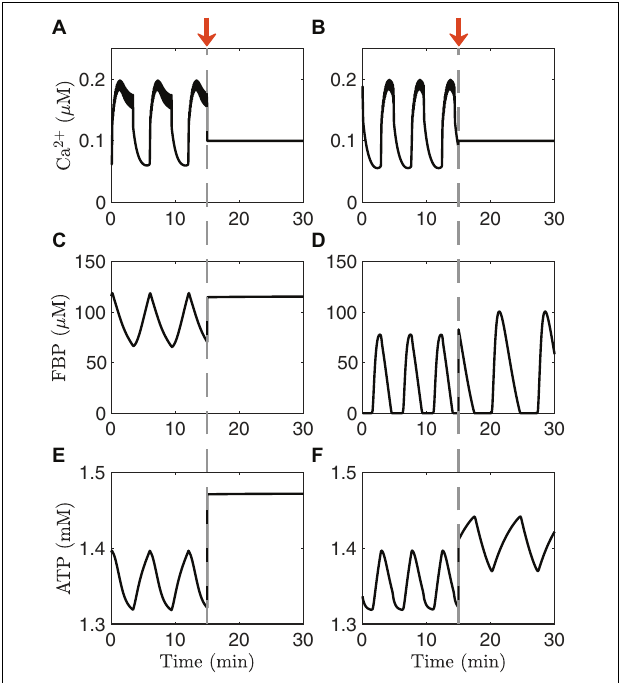
FIGURE 3 | Time courses generated with the IOM. The columns on the left (A,C,E) show an example of PMOs, while those on the right (B,D,F) show an example of AMOs. For the left column, v PDH = 0.4 µ M / ms while for the right column and v PDH = 2 µ M / ms. In both cases, g K ( Ca ) = 150 pS and the glucose concentration in 11 mM.